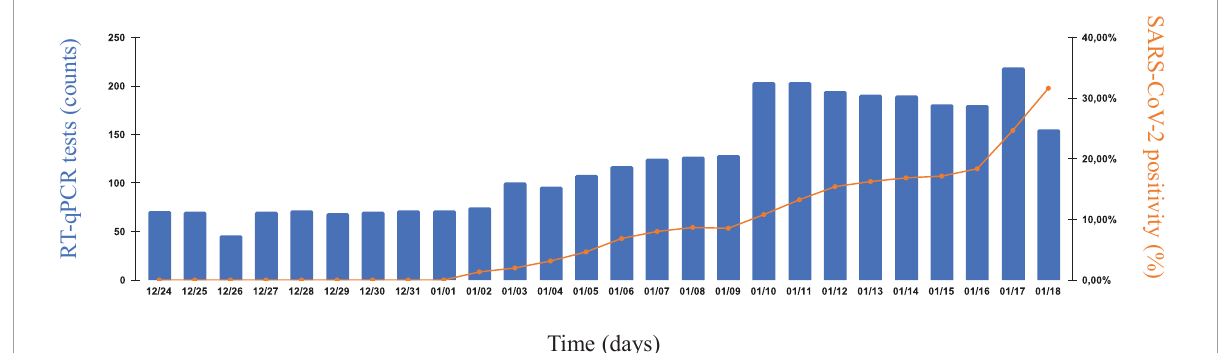
FIGURE1 The new year uprise of SARS-CoV-2 cases in industrial and service companies of Rio de Janeiro. SARS-CoV-2 infection rates in nasopharyngeal swab samples collected from 25 December 2021 to 18 January 2022, as part of coordinated and continuous effort to monitor COVID-19 in companies of the state of Rio de Janeiro (RJ), Brazil. Samples were collected from syndromic and non-syndromic workers. Left vertical axis, number of SARS-CoV-2-specific RT-qPCR tests performed daily. Right vertical axis, SARS-CoV-2 percent positivity index (%). Horizontal axis, chronological time (as consecutive days of monitoring).